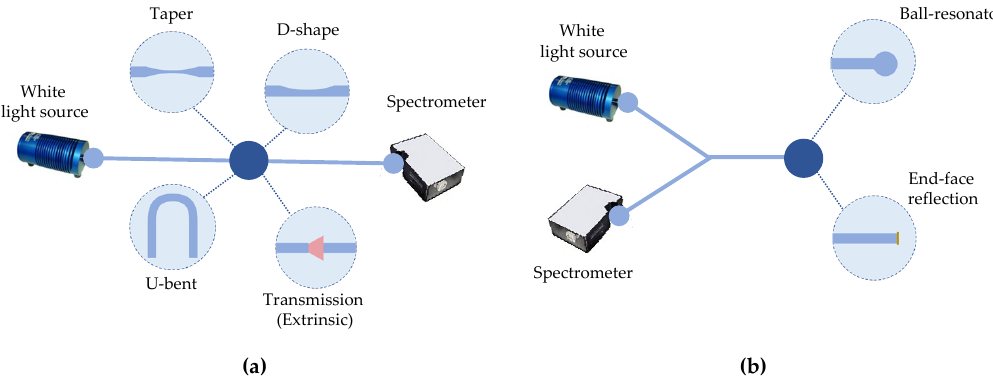
Figure 2. Schematics of OFB working in ( a ) transmission and ( b ) reflection.